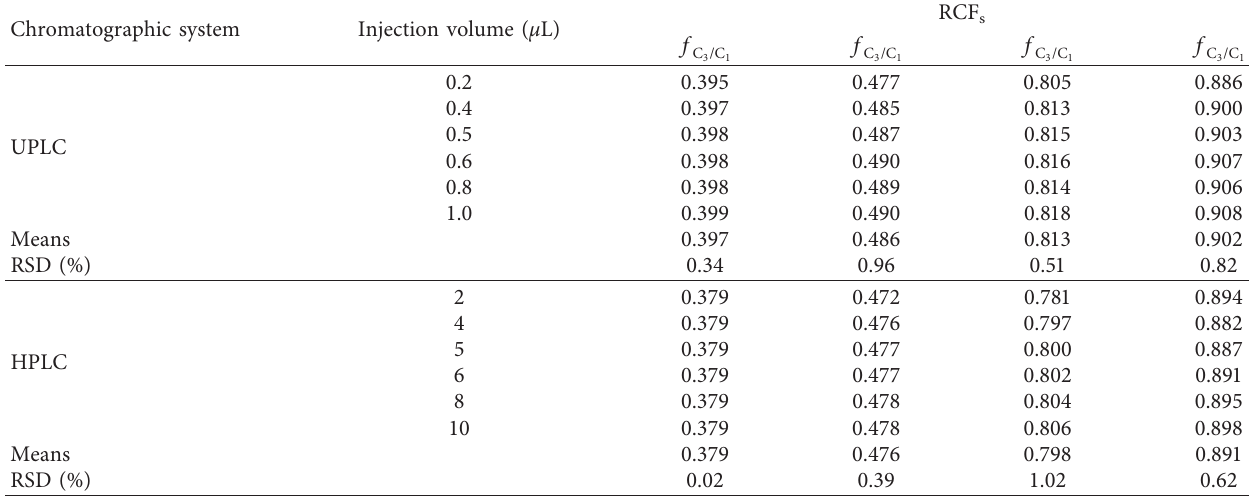
s /i of 5 constituents.